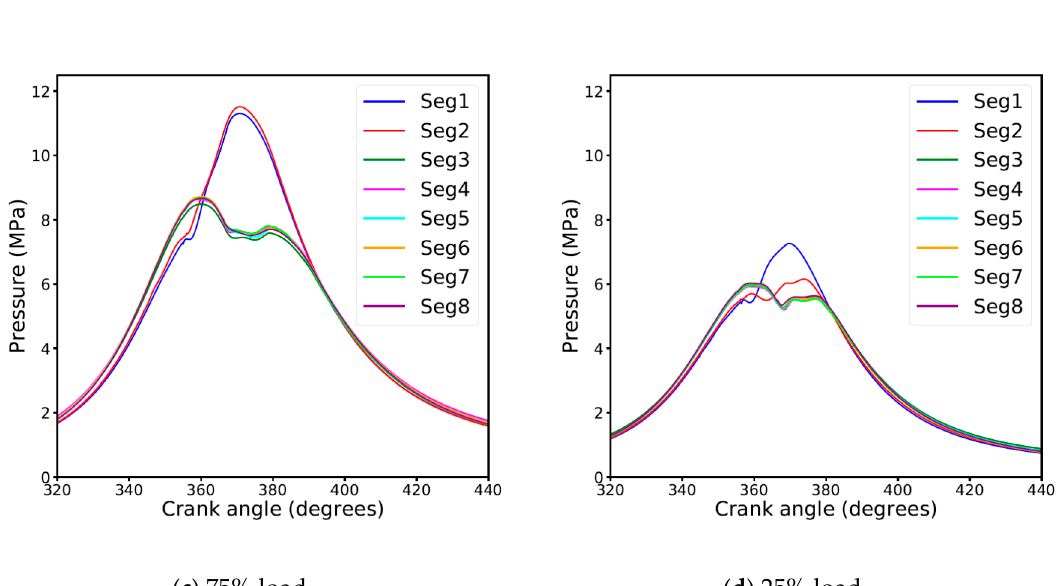
Figure 3. In-cylinder pressure in each segment at 1500 rpm at ( a ) 100% load, ( b ) 50% load, ( c ) 75% load and ( d ) 25% load. The blue line represents Segment 1, red line represents Segment 2, green line represents Segment 3, magenta line represents Segment 4, cyan line represents Segment 5, orange line represents Segment 6, lime line represents Segment 7 and purple line represents Segment 8.